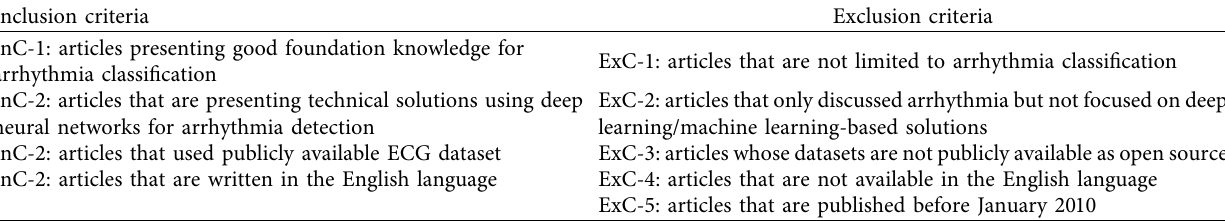
Table 1: Selection